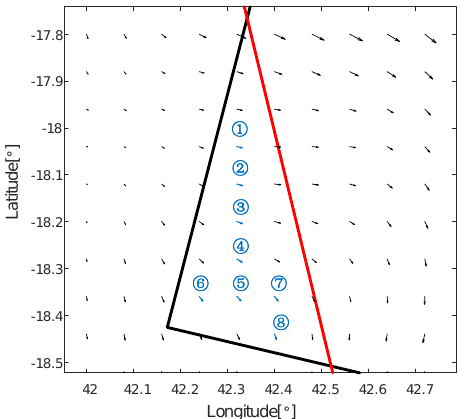
Figure 9. Location points in the current field as